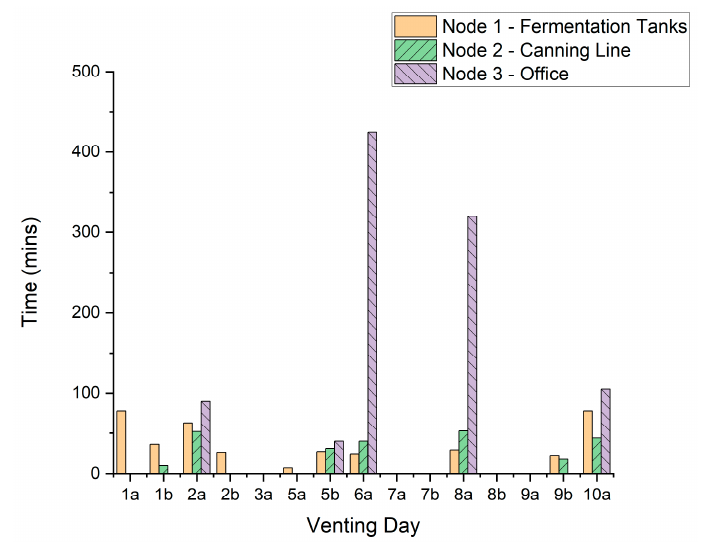
Figure 7. Consecutive time the CO 2 concentration remained above 1000 ppm for each venting event. The maximum consecutive amount of time CO 2 levels exceed 1000 ppm for each node is 425 min for Node 3, 78 min for Node 1 and 53 min for Node 2. 10,000 ppm is exceeded in two cases for durations of 26 min for Node 3 and 3 min for Node 1.